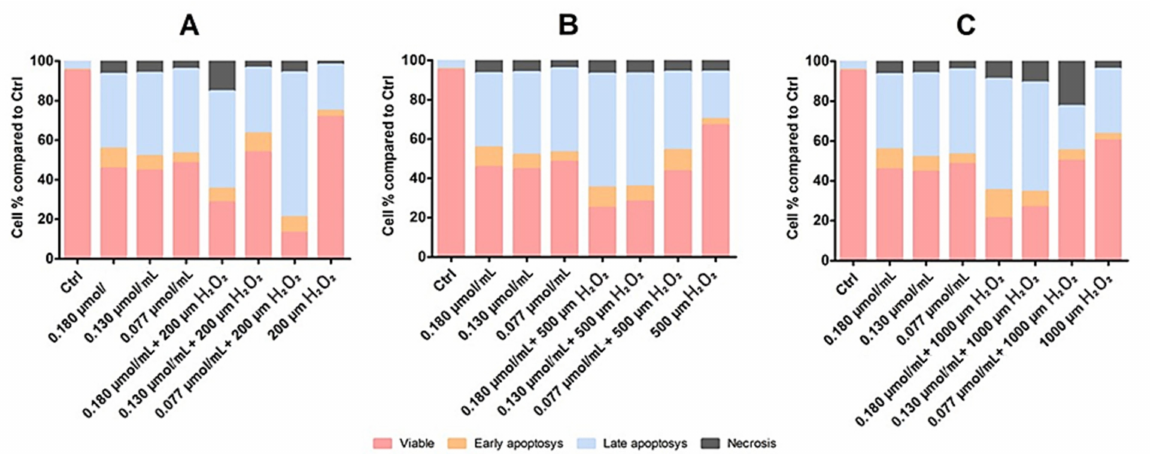
Figure 11. Flow-cytometry analysis of B16F10 cells following rhodoxanthin and hydrogen peroxide exposure. ( A ) B16F10 cells exposed to C1–C3 and 200 µ m H 2 O 2 . Significance: p < 0.05. ( B )